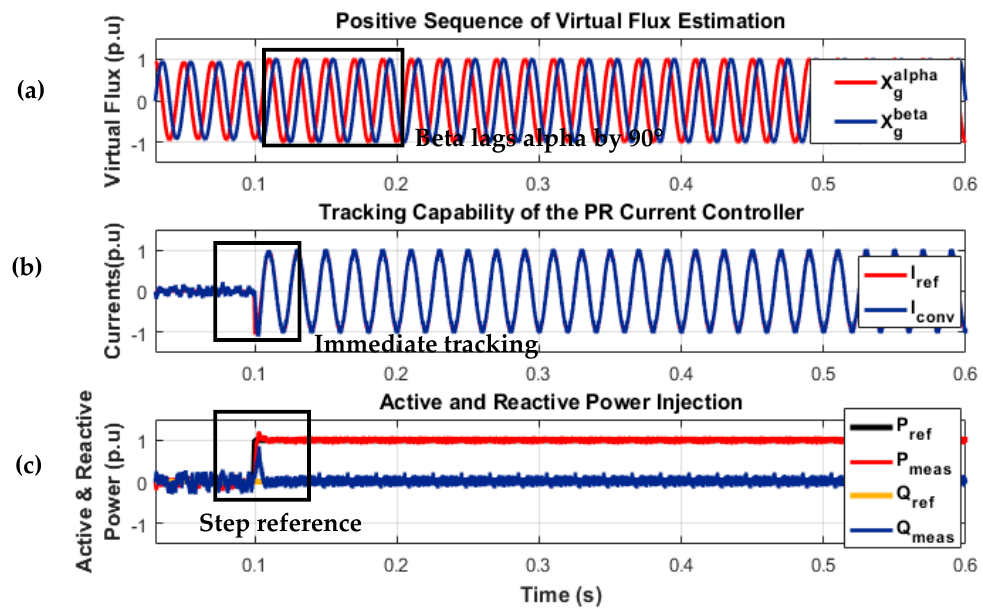
Figure 11. Simulation results: ( a ) Positive sequence of VF estimation after transformer, T 1 ; ( b ) Tracking capability of the system of the current controller; ( c ) Active & reactive power injection to the grid.